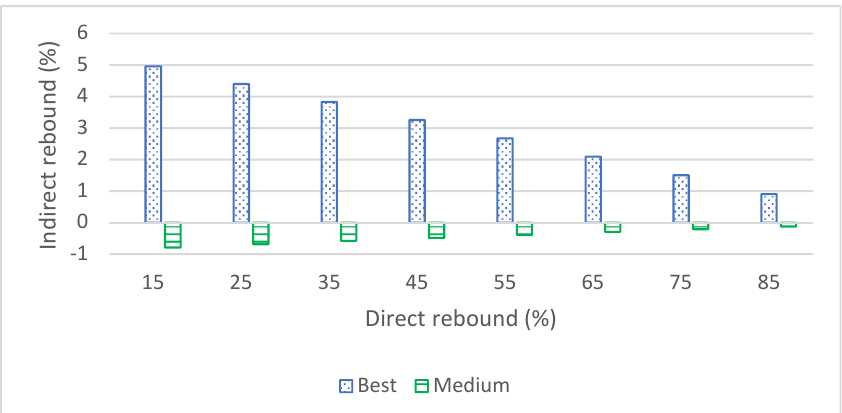
Figure 1. The indirect rebound effect at the national level with various assumed direct rebound effect of an efficiency improvement of electricity used by households in China. The calculation is based on an input–output model using the 2017 data.